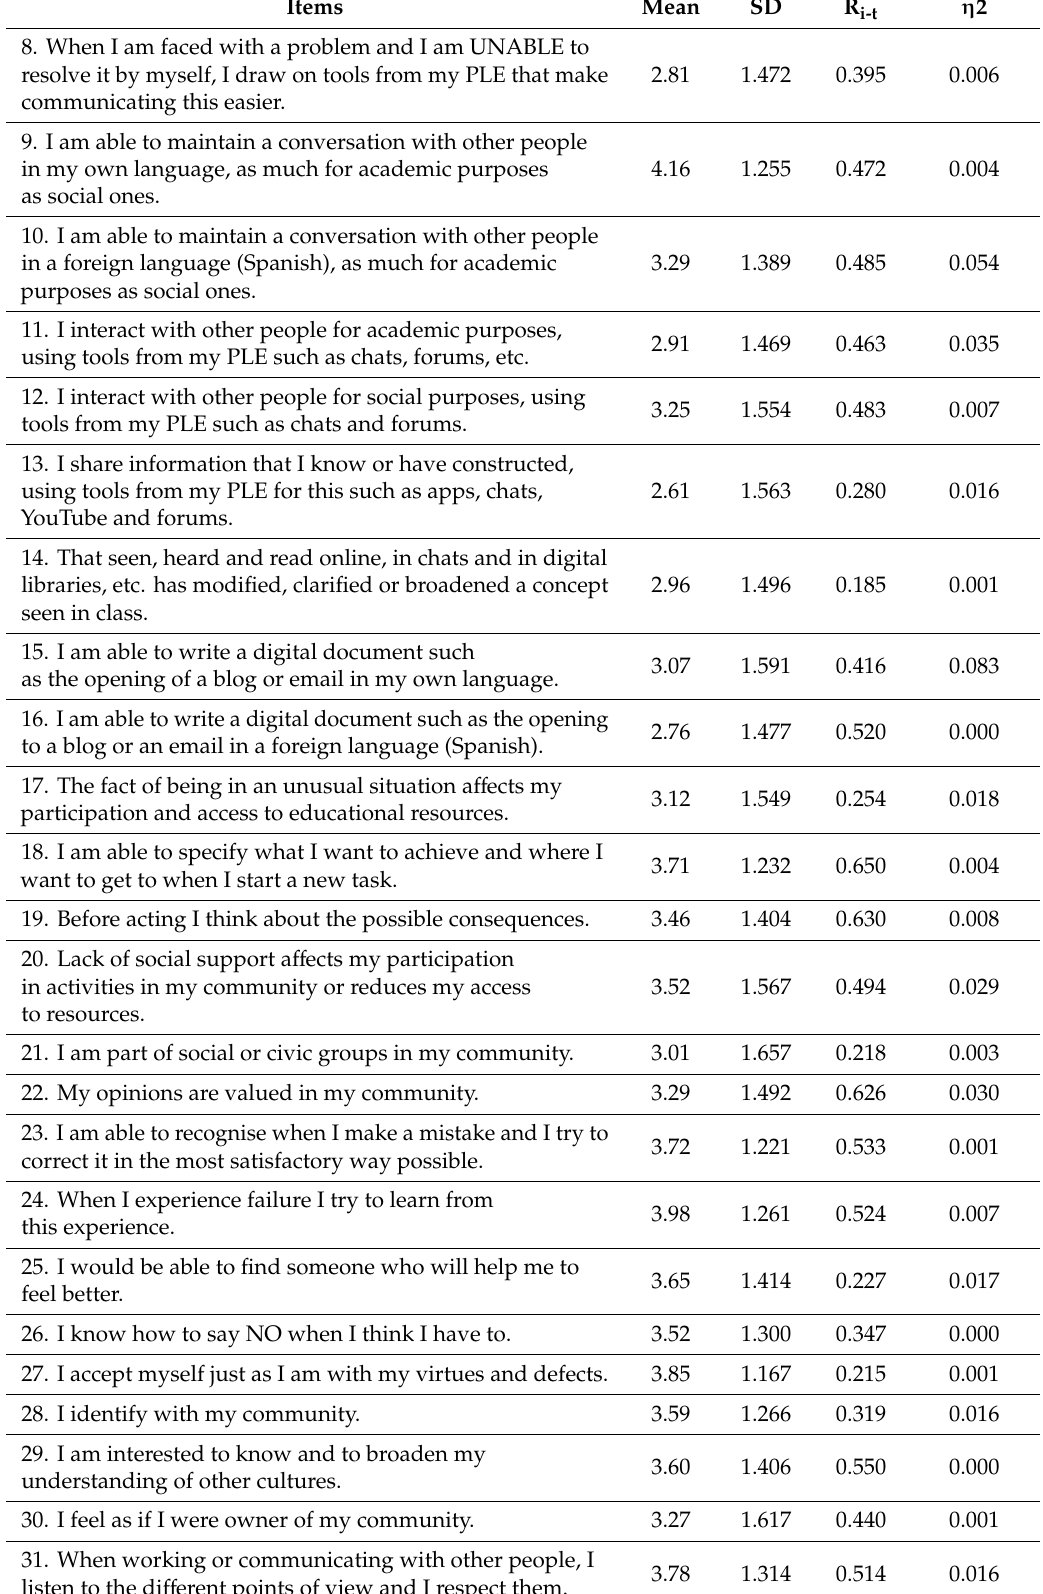
Items Mean SD R i-t η